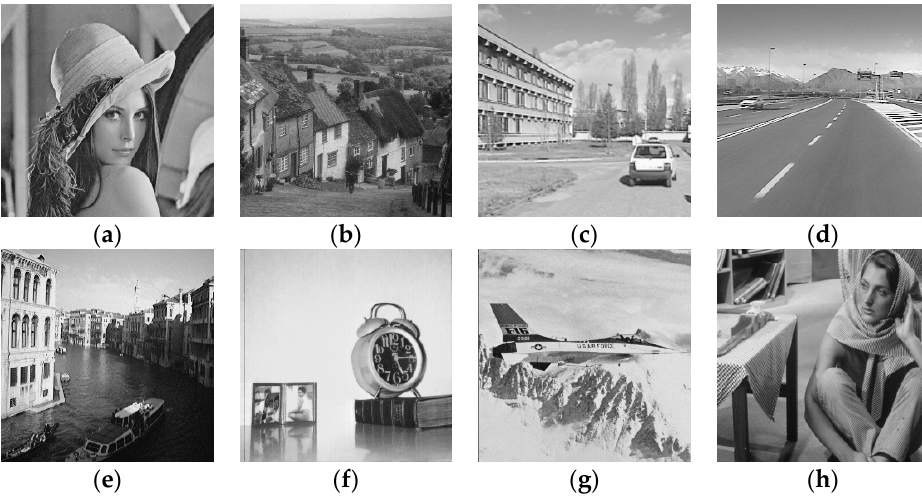
Figure 6. Test images: ( a ) Lena; ( b ) Goldhill; ( c ) Car1; ( d ) Car2; ( e ) Venice; ( f ) Clock; ( g ) Airplane; ( h ) Barbara.